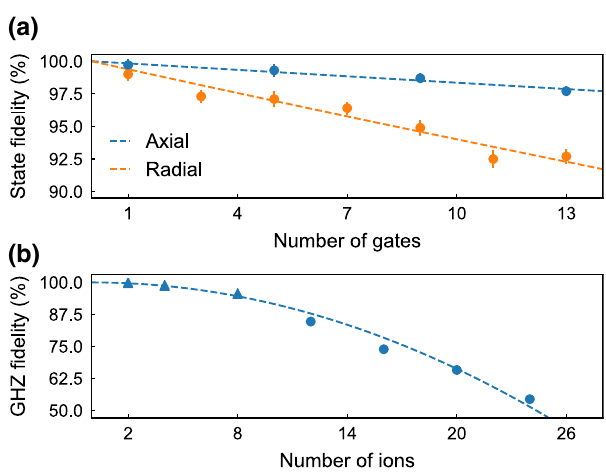
FIG. 17. Mølmer-Sørensen gate performance. (a) Decay of overall state fidelity after repeated, odd-integer application of approximately 200 μ s Mølmer-Sørensen interactions for axial and radial two-ion gates. We infer a single-gate state fidelity of 0.9983 ± 0.0001 per axial gate and 0.9936 ± 0.0003 per radial